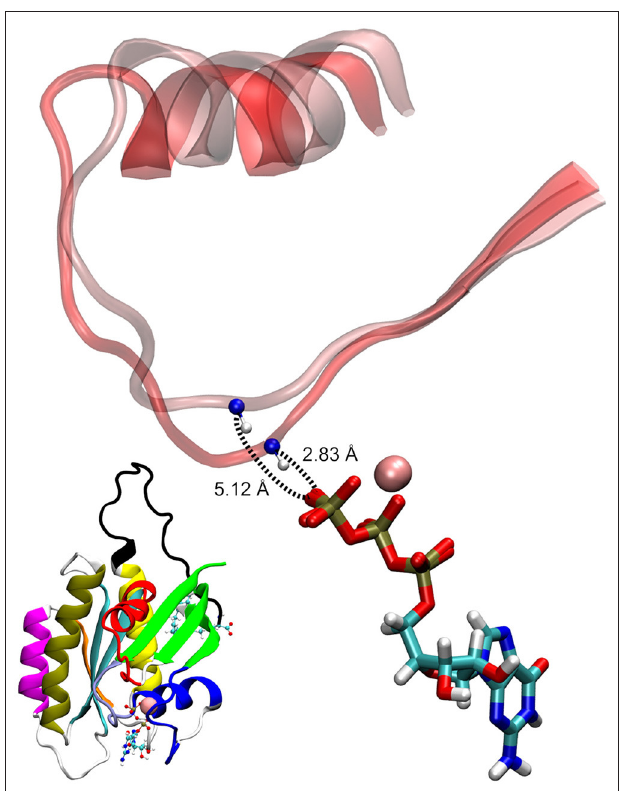
FIGURE 6 | Examples of GTP-bound K-Ras4B in state 1 and state 2, superimposed at their nucleotides. The shorter donor-acceptor distance corresponds to state 2.